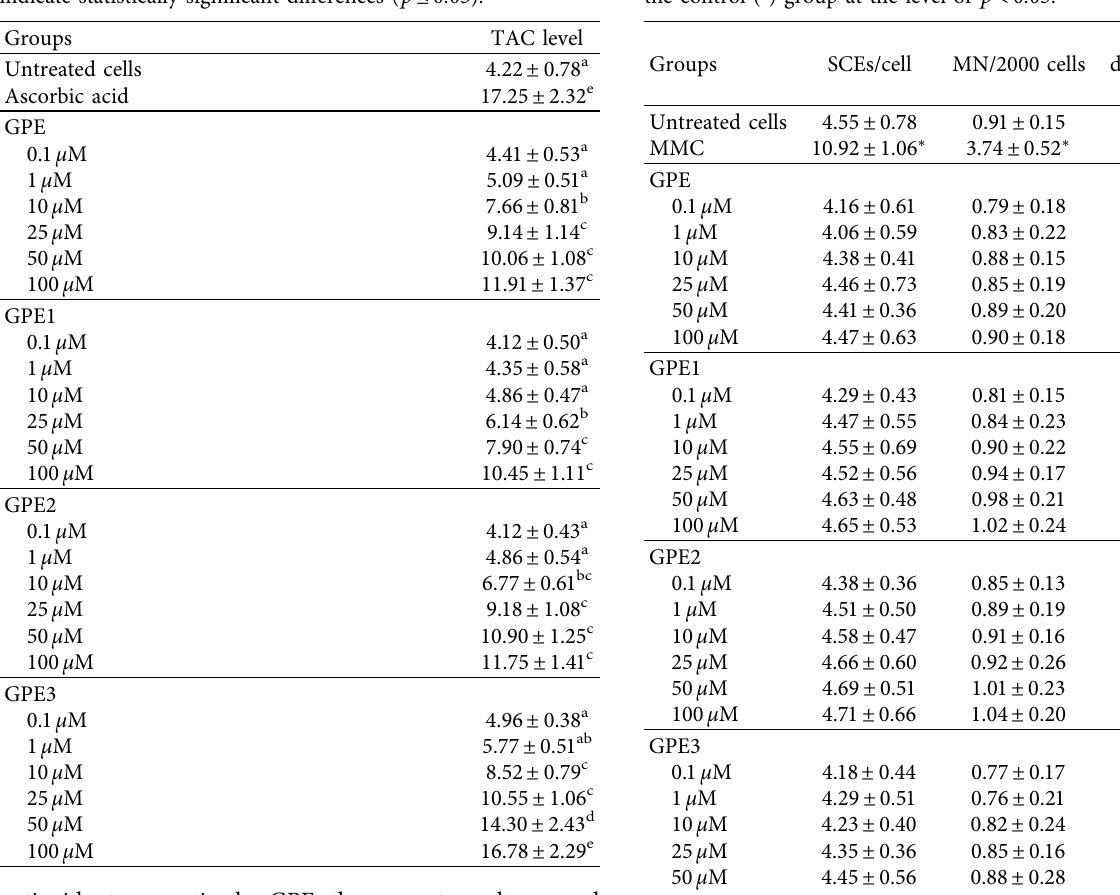
Table 1: Te efects of GPE and novel GPE analogs on TAC level (as mmol Trolox Equiv./L) in cultured PHWB cells. Diferent letters indicate statistically signifcant diferences ( p ≤ 0 .